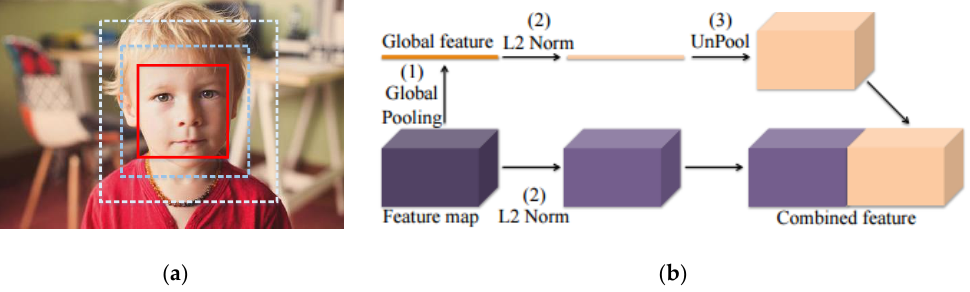
Figure 1. Two context adding approaches. ( a ) Red window is the original bounding box and the dashed windows are the enlarged windows; ( b ) Using global pooling to incorporate global pixel information.